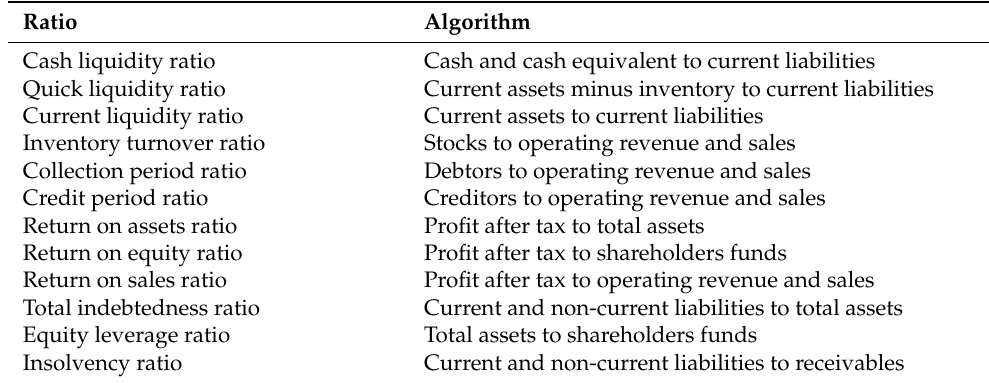
Table 3. Summarized formulas of financial